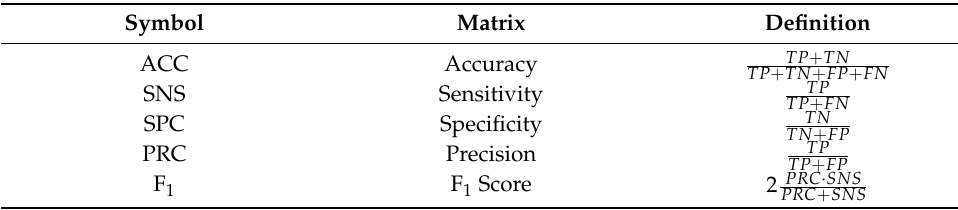
Table 4. List of rates definition computed from the confusion